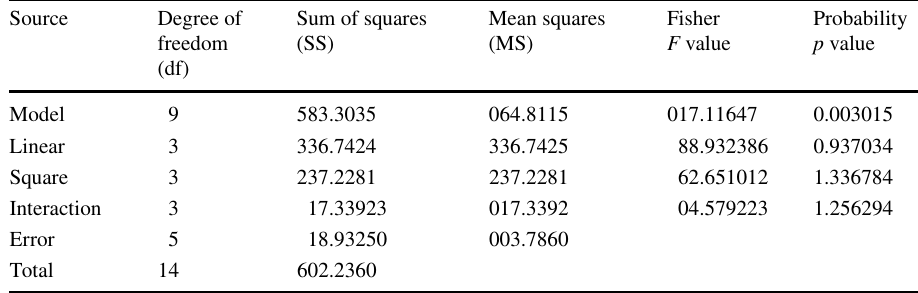
R 2 = 96.86%, adj R 2 =